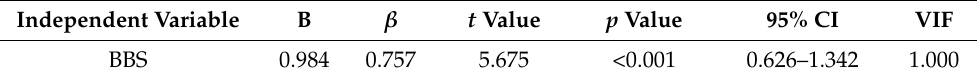
Table 3. Clinical factors associated with the leg extension angle on the affected side in stepwise multiple regression